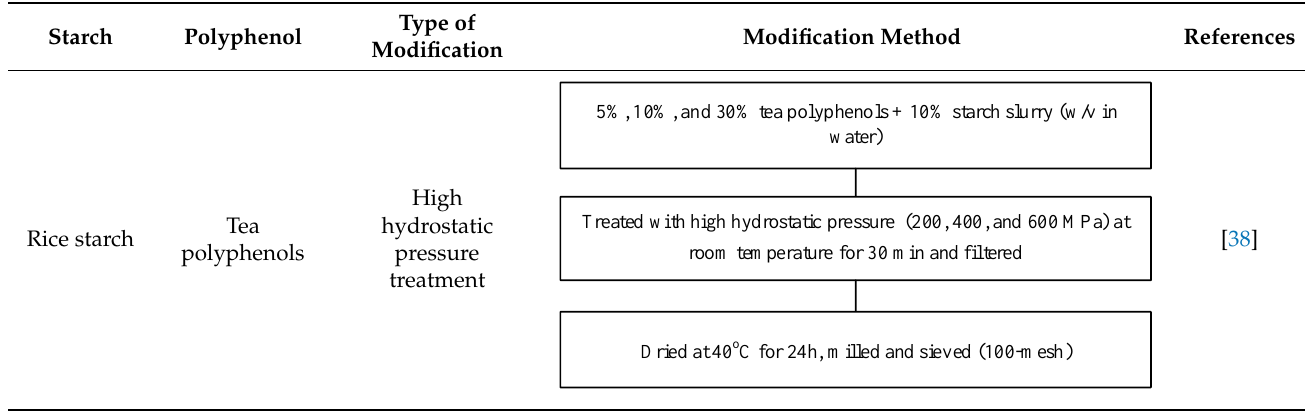
Table 4. Current methods for producing starch–polyphenol complexes.